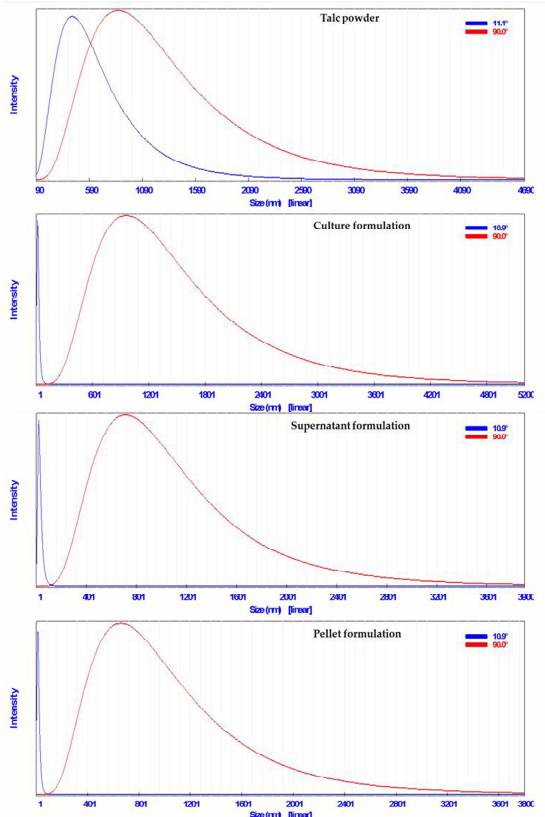
Figure 6. Particles size of talc-based formulations of Streptomyces cellulosae Actino 48. 3.5. Application of Bio-Friendly Formulations of Chitinase-Producing S. cellulosae Actino 48